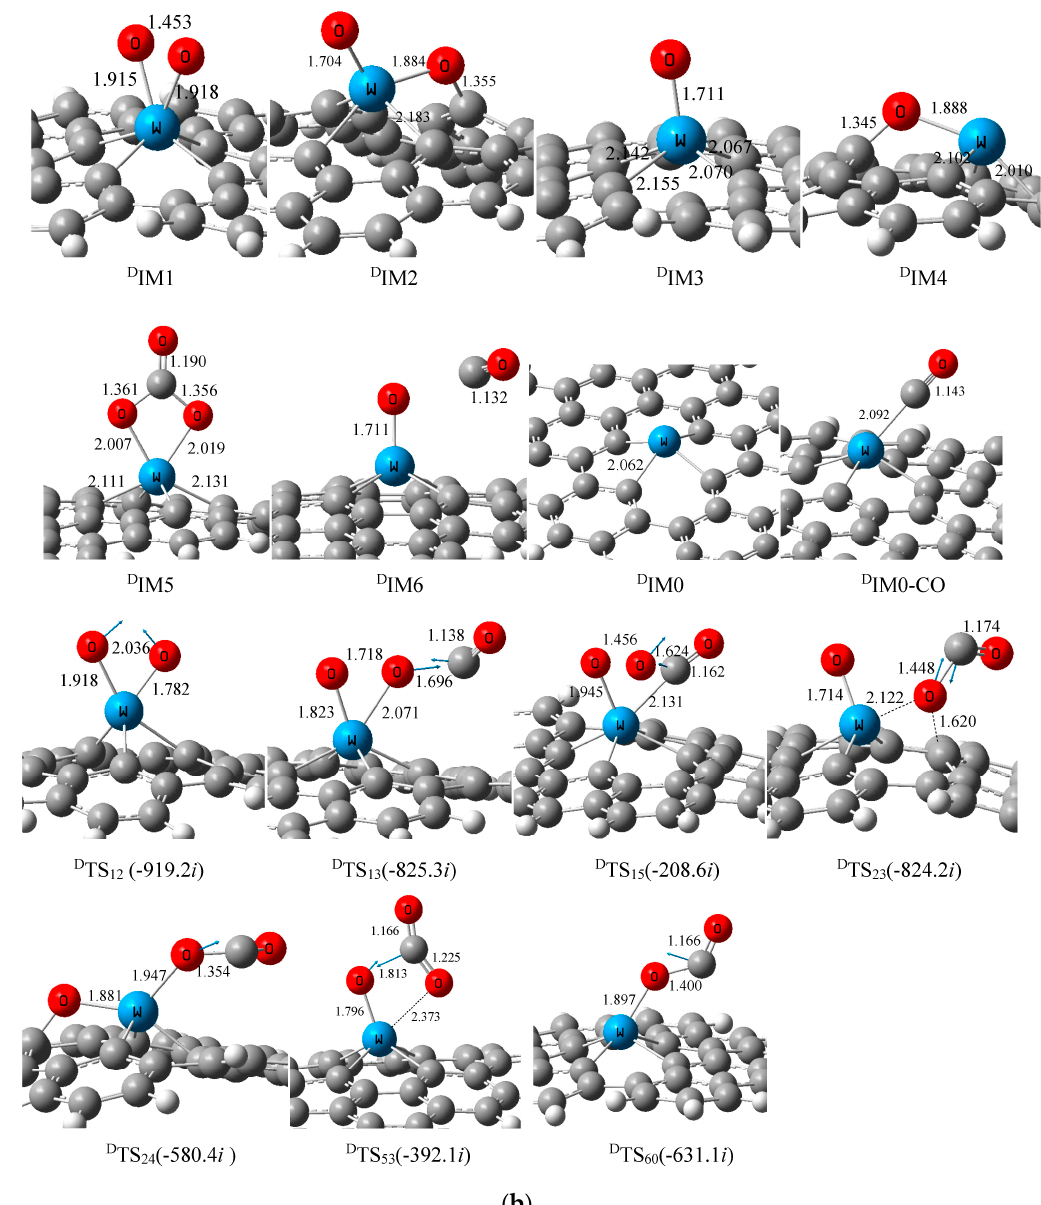
Figure 1. ( a ) Optimized structures over W-SV-graphene (distances in Å). ( b ) Optimized structures over W-DV-graphene (distances in Å).